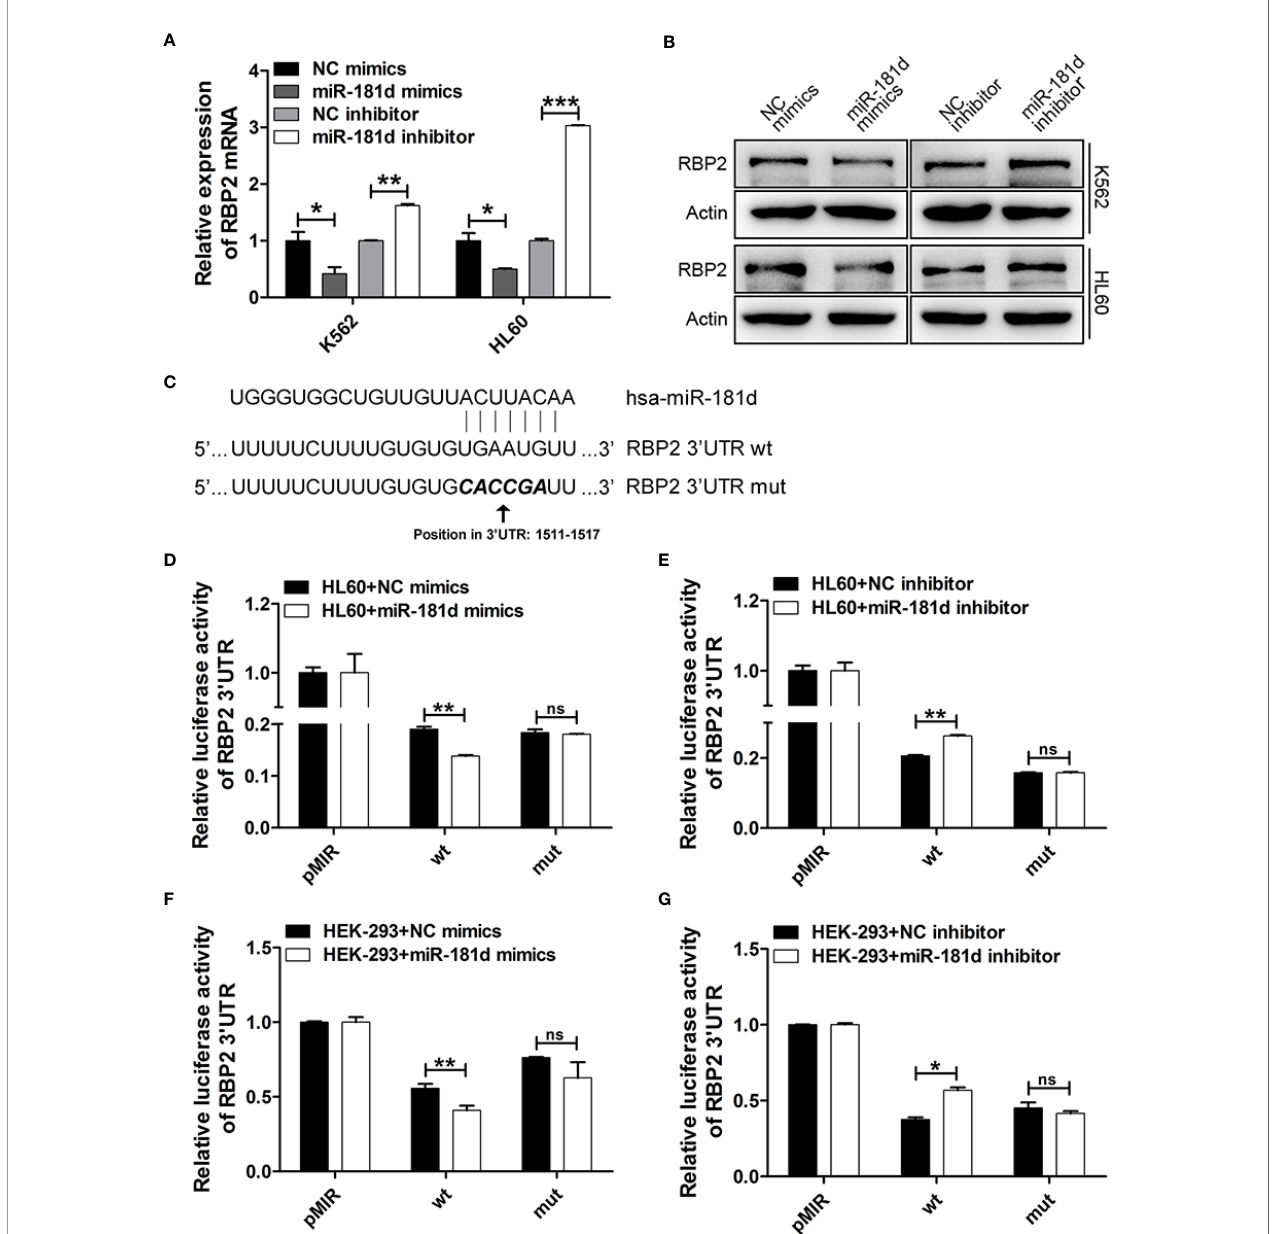
FIGURE 2 | miR-181d directly regulates RBP2 expression. (A, B) qRT-PCR and Western blot analysis of RBP2 mRNA and protein levels after transfection with miR- 181d mimics or inhibitor. (C) Schematic illustration of the predicted miR-181d binding sites in RBP2 3 ′ -UTR. (D – G) RBP2 wild type 3 ′ UTR and its mutated activity following miR-181d mimics/inhibitor transfection in HL60 and HEK-293 cells. Luciferase activities were determined at 48 h and normalized by Renilla luciferase activity. The results are from 3 independent experiments. * p < 0.05, ** p < 0.01, *** p < 0.001, ns, not statistically signi fi